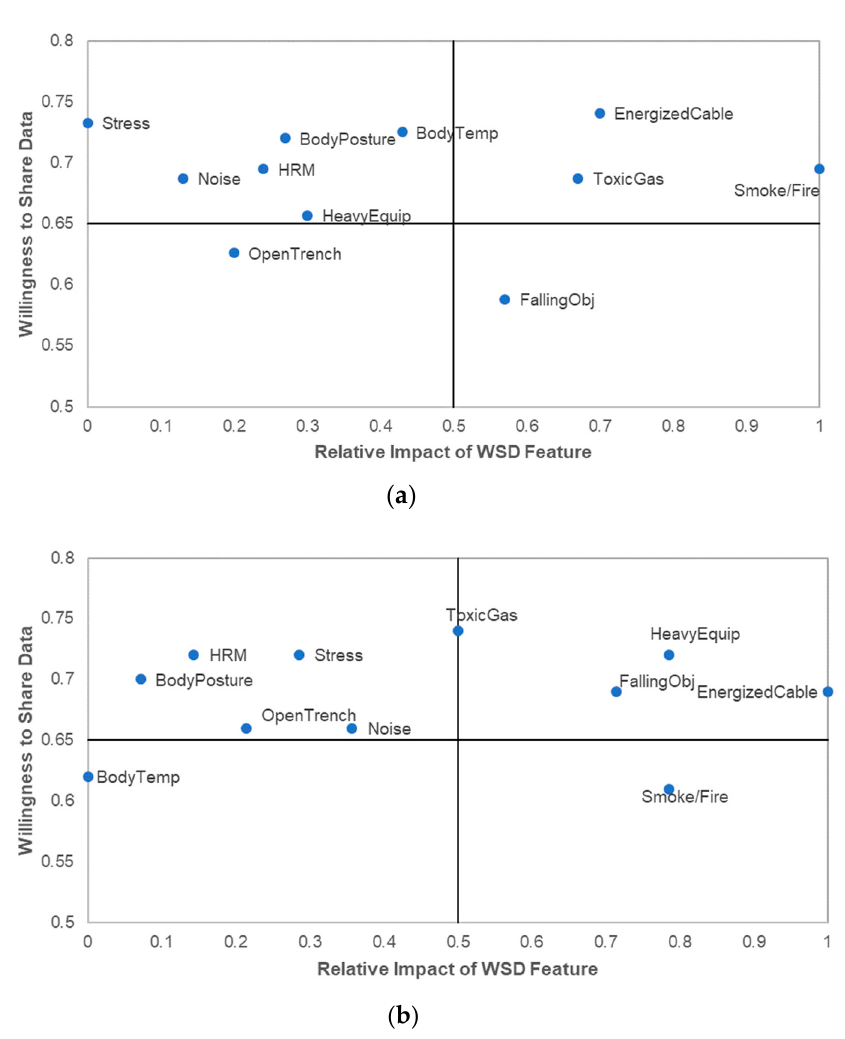
Figure 4. WSD function Impact–Willingness to Share 2 × 2 Matrix ( a ) FW; ( b ) MP. The researchers modified the position of some nodes to help with visual clarity. However, these changes did not distort the position of the functions relative to their respective quadrants, thereby ensuring that interpretation was not impacted.